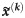
Mapping x(k) to x˜(k).